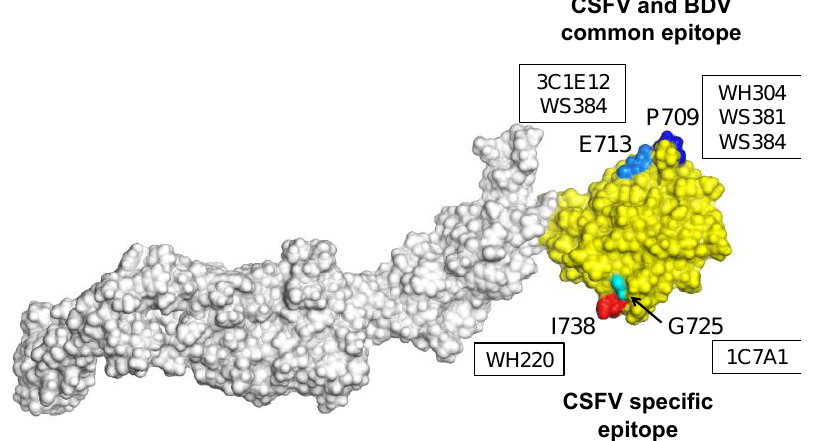
Figure 4. The 3D structure modeling of E2 of CSFV strain TD/96. The domains B/C are colored yellow. The residues P709, E713, G725 and I738 recognized by mAbs are highlighted with dark blue, light blue, light green and red, respectively. The mAbs recognizing the highlighted amino acid residues are indicated in boxes.